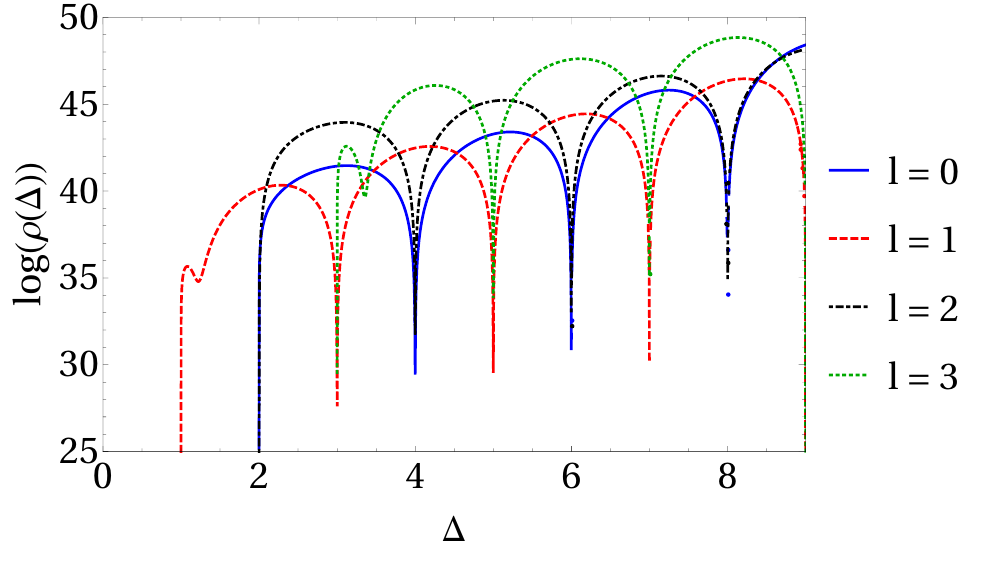
Figure 9 . Extremal functional of c = 8 theory, at n D =